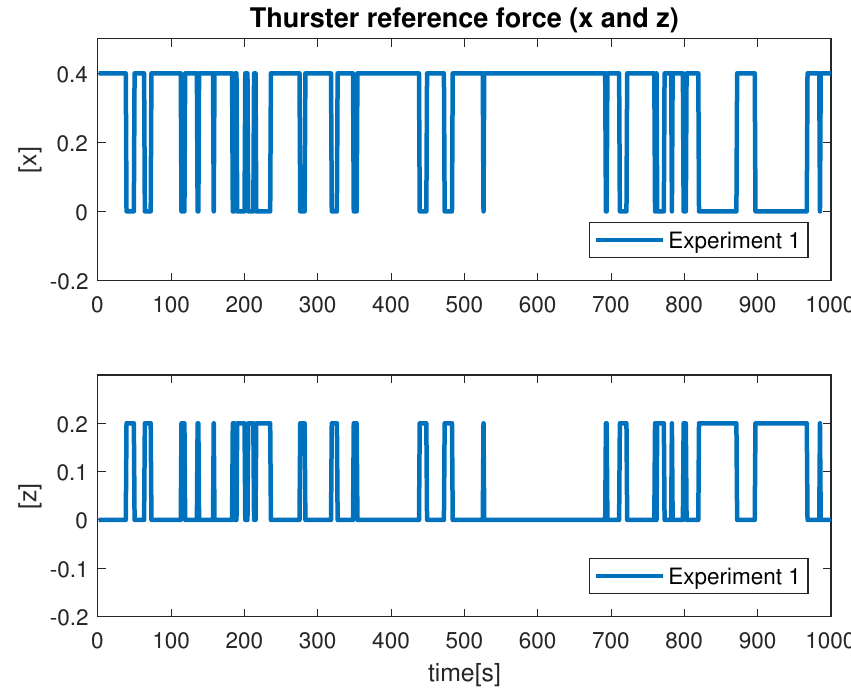
Figure 22. Velocity profile during Experiment